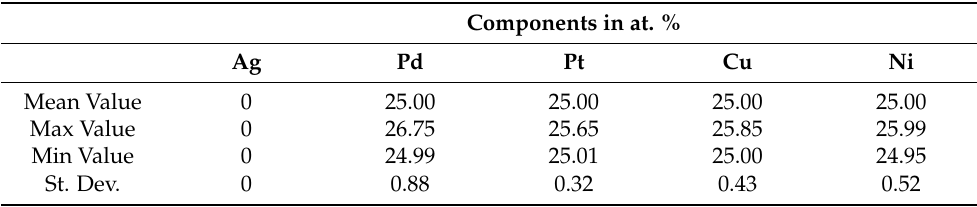
Table 3. Chemical composition of a cast CCNA sample after DSC analysis (cooling rate 0.5 °C/min) identified by EDS analyses.